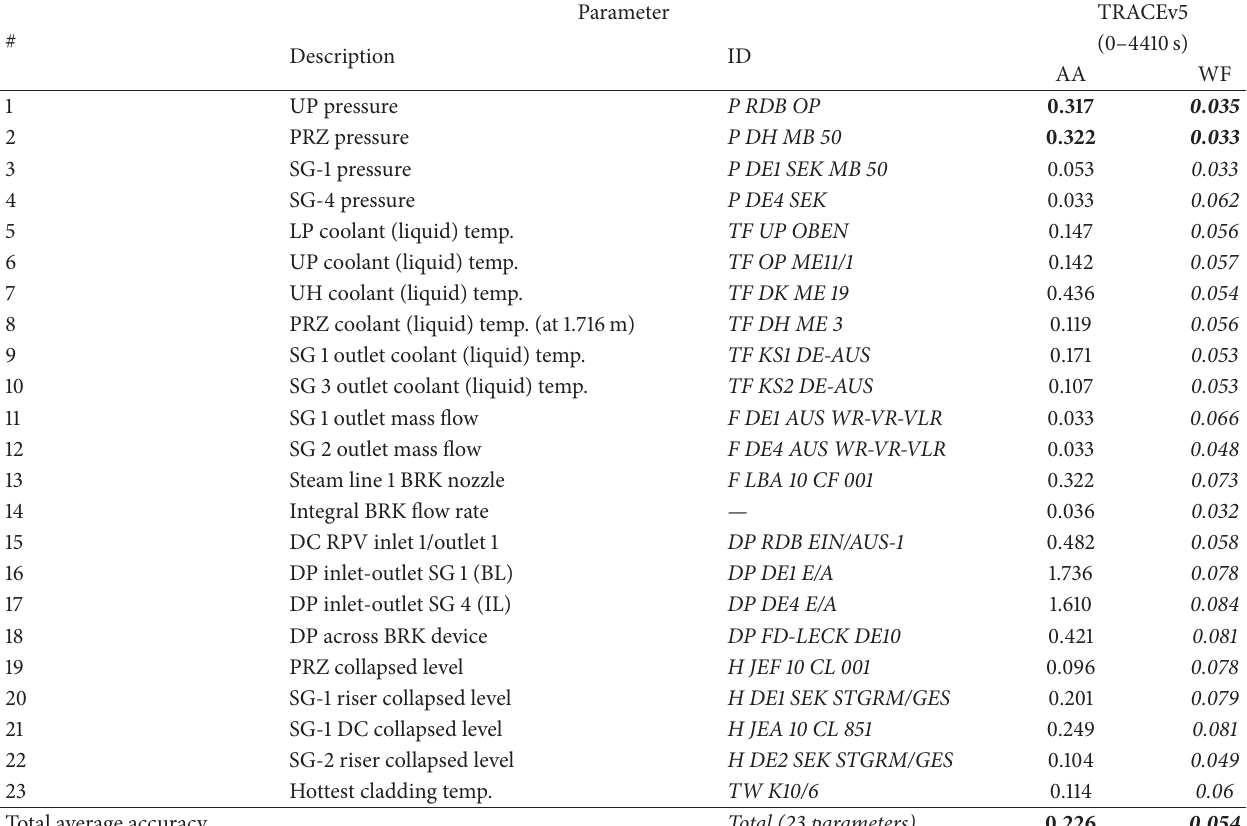
Table 3: Post test: summary of results obtained by application of FFT-BM—overall